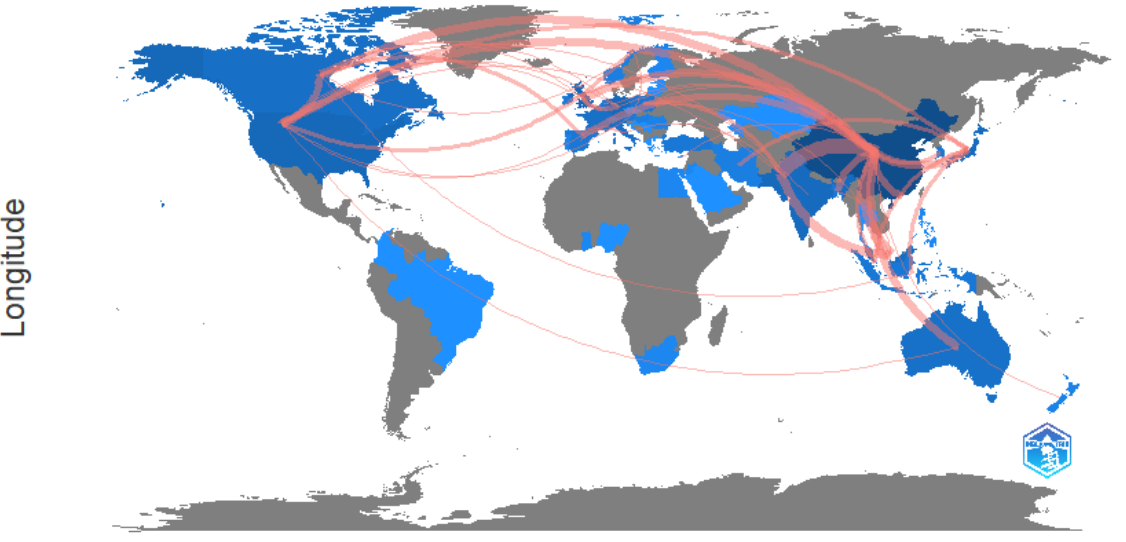
Figure 8. Countries’ collaboration map.